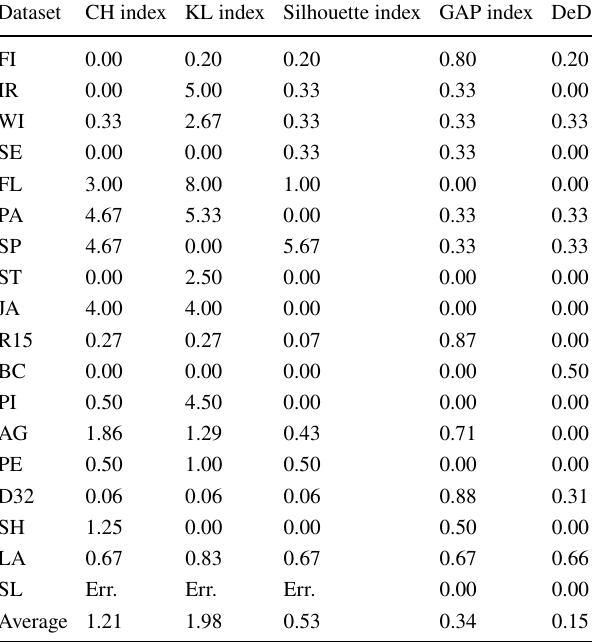
Table 7 The adjusted Rand index (ARI) for the clustering at each estimated k in the